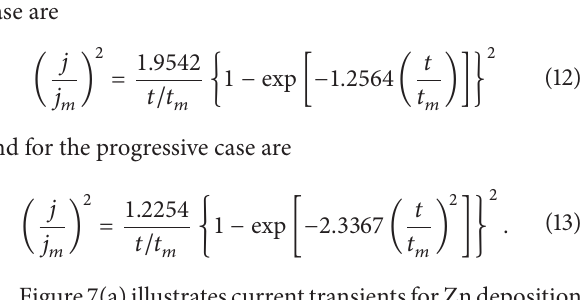
onto GaN electrode within potential range from 1.25 V to 1.4 V. Regardless of the electrode potential all the curves have similar shape and are characterized by sharp increase of cathodic current at the initial stages of deposition followed by a drop at longer times. These features of current transients are relevant to 3D Zn nucleation followed by diffusion limited growth. Figure 7(b) shows the normalized cathodic transients from Figure 7(a) together with the theoretical curves for instantaneous and progressive 3D nucleation and growth based on (12) and (13). Figure 7(c) shows a series of deposition transients for deposition of zinc from the different concentration of ZnSO 4 and same potential ( − 1.4 V). The black lines of Figures 7(b) and 7(d) are the theoretical curves for instantaneous and progressive nucleation. From the results in Figure 7(b), in which the solution concentration of ZnSO 4 is 10 mM, the first half of the nucleation plot has good correlation with the theoretical curve for instantaneous nucleation, while the second half of the nucleation plots transition from progressive to instantaneous nucleation with the potentials increasing from − 1.25 V (green lines) to − 1.4 V (red lines). Meanwhile, we can know that the mechanism of Zn is different at various concentration from Figure 7(d) and the red, green, and blue lines are the 5 mM, 10 mM, and 20 mM. The nucleation plots transition is gradually